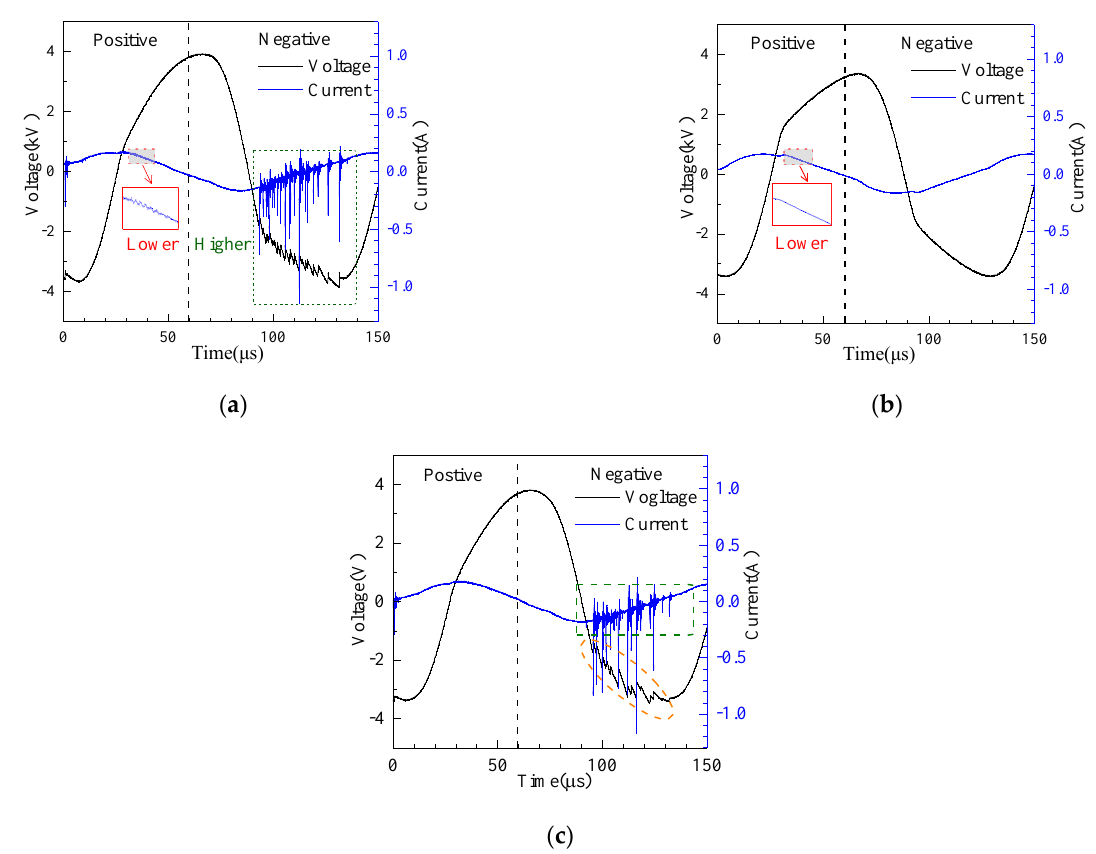
Figure 5. Current—voltage waveforms of SDBOR ( a ), DDBOR ( b ), and DBD reactor without silver layer ( c ) (discharge gap = 0.5 mm, applied voltage = 2.8 kV, the marked positive and negative refers to current).